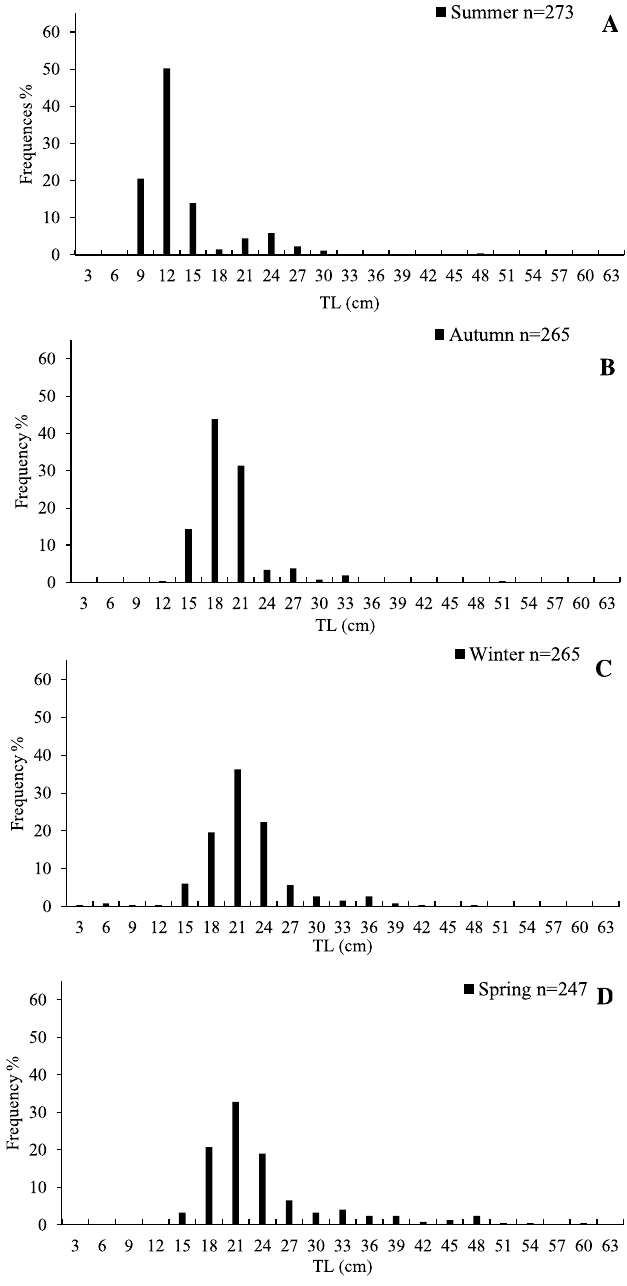
Fig. 6. Seasonal lenght frequency distribution of P. blennoides from landings of commercial fi sheries (A: Summer, B: Autumn, C: Winter, D: Spring, n: number of